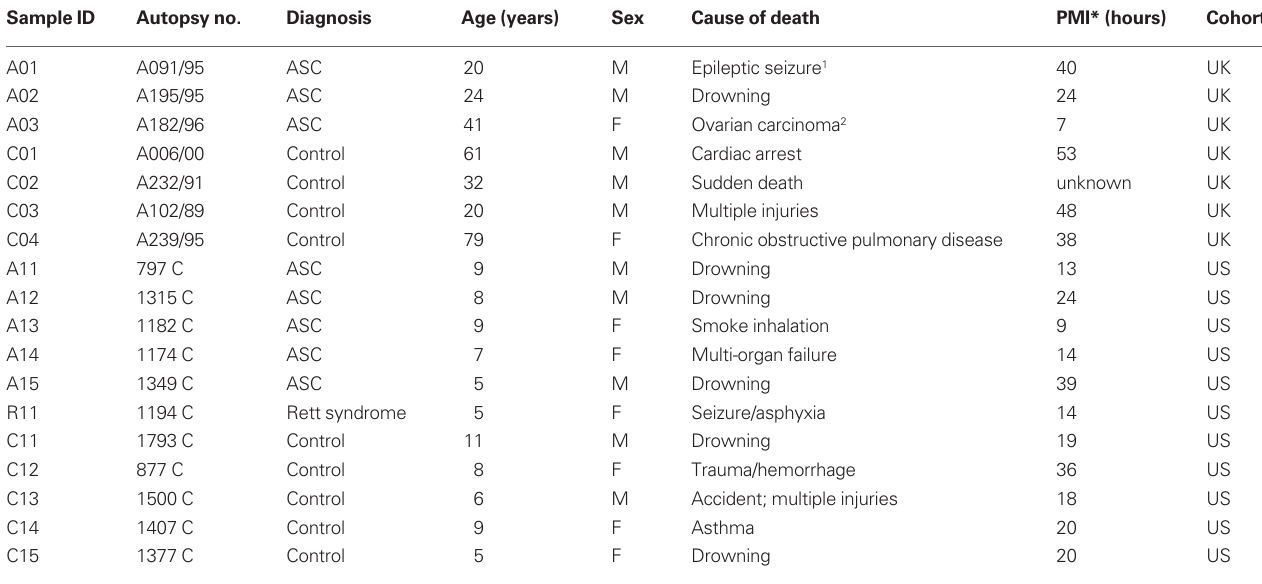
Table 1 | Demographic information on tissue donors for the UK (London Brain Bank) and US (Autism Tissue Program/Harvard Brain Tissue Resource Center)